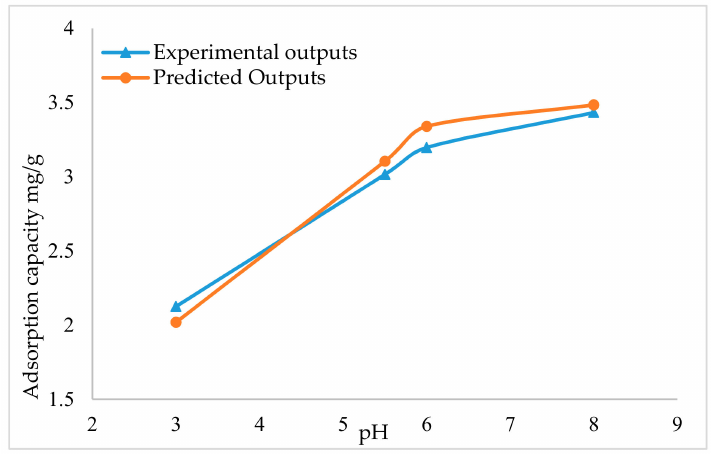
Figure 1. E ff ect of pH on adsorption capacity.